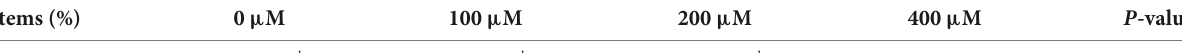
TABLE 7 Effects of UR on the distribution of cell cycle in pTr2